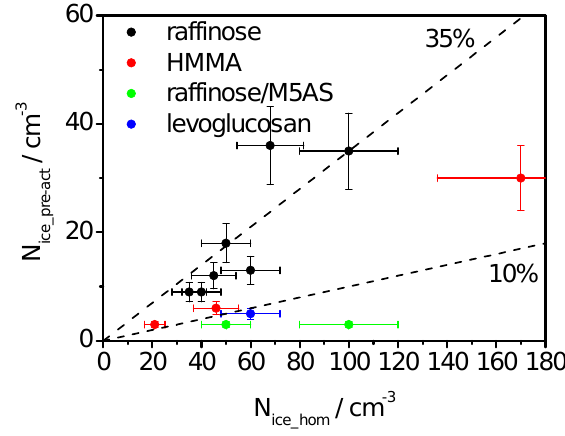
Fig. 15. Correlation of the ice particle number concentrations between homogeneous freezing, N ice hom , and pre-activation, N ice pre-act , for all couples of succeeding expansion runs that were conducted in the present study with the four different compounds. The two dashed lines denote 10 and 35% fractions of N ice hom .